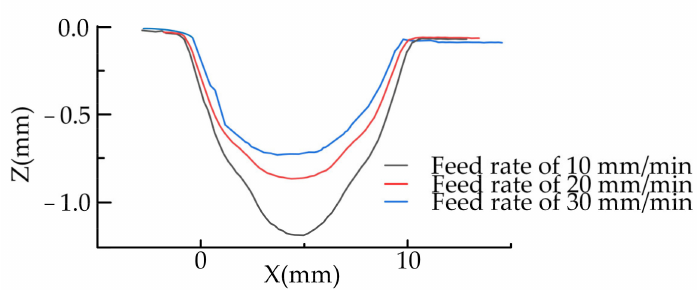
Figure 9. Cross-sectional profiles of machined grooves under different feed rates.